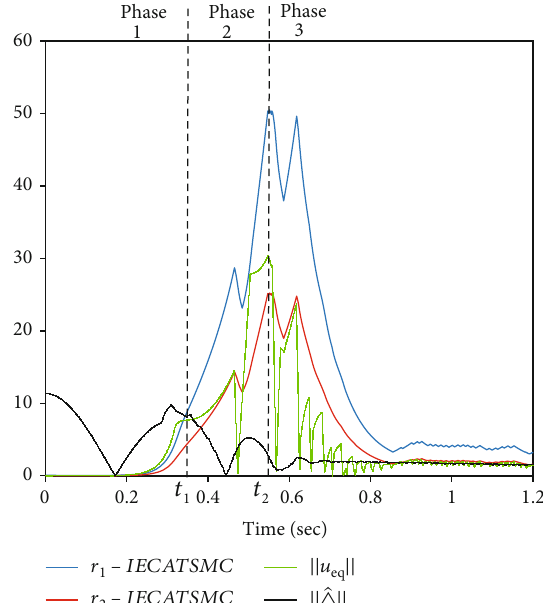
Figure 7: Gains in three